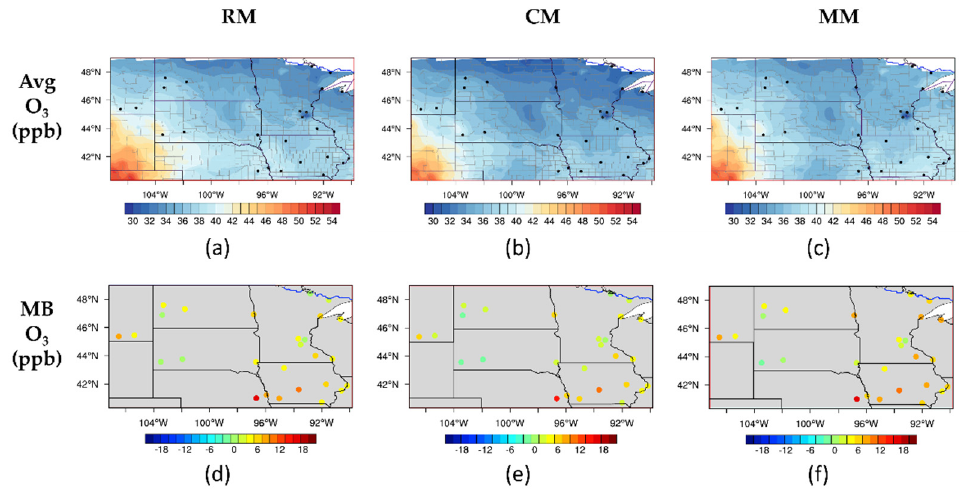
Figure 4. Monthly average of predicted hourly O 3 concentrations (ppb) during July 2010. Model predictions for ( a ) RACM-MADE/SORGAM (RM), ( b ) CBMZ-MOSAIC (CM), and ( c ) MOZART- MOSAIC (MM). Mean bias of model predictions against observations for ( d ) RM, ( e ) CM, and ( f ) MM.